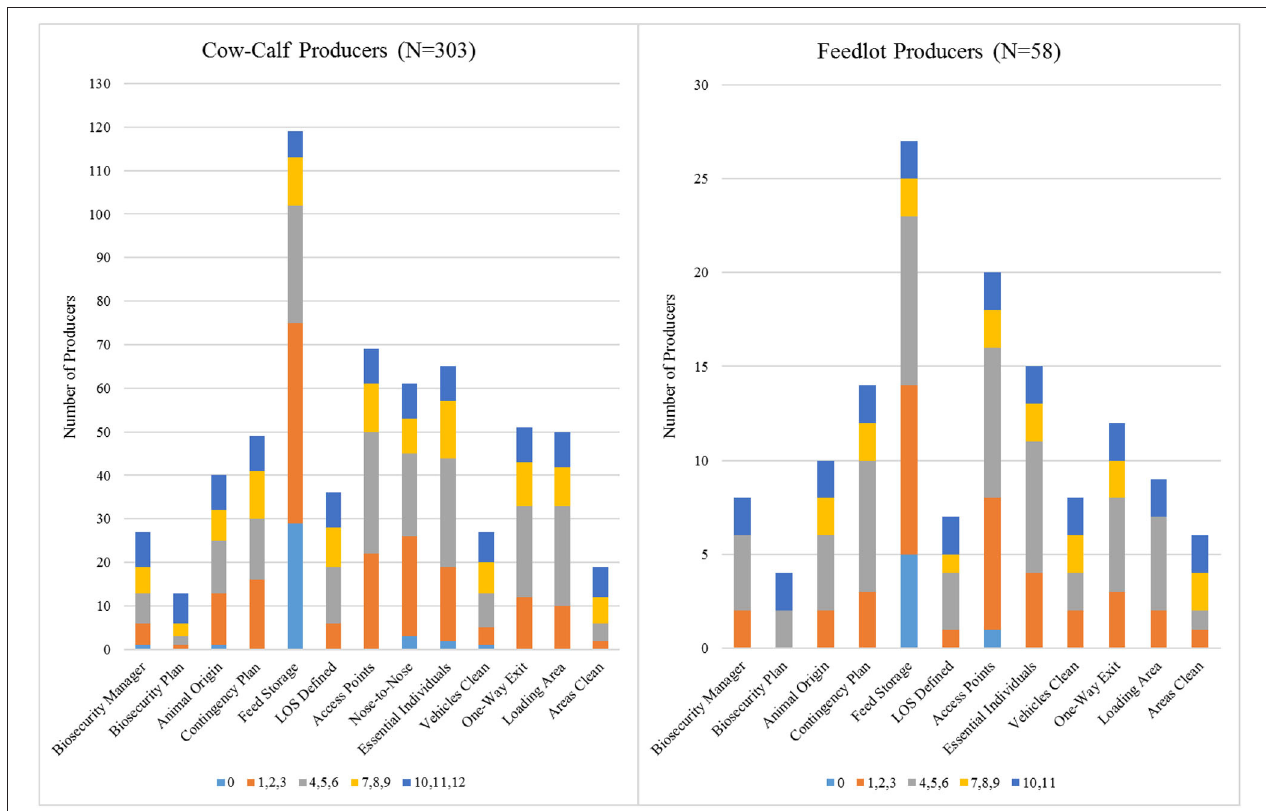
FIGURE 1 | Complementarity of enhanced biosecurity practices as shown by number of other practices adopted by adoptees of a given practice. The vertical axis shows how many producers in N have adopted the practice named on the horizontal axis. Categories are combined for the sake of